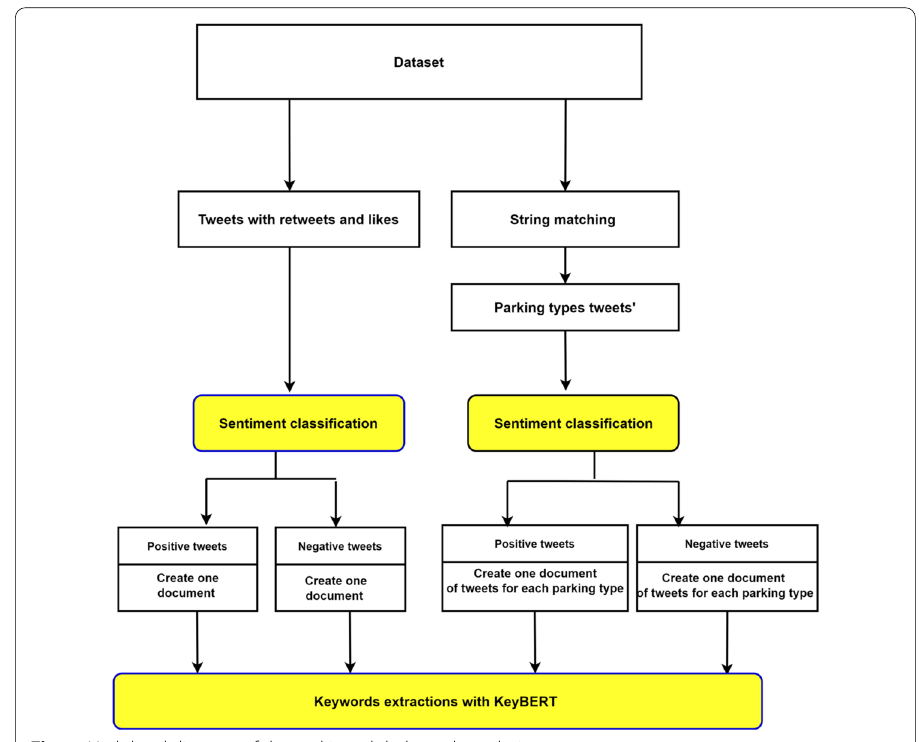
Fig. 1 High level diagram of the parking global trends